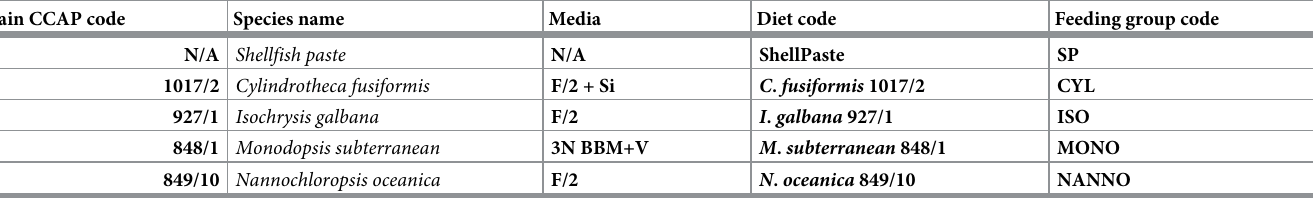
Table 1. Summary of diets employed during the feeding trial. For the live algae treatments, media used in the culture of microalgae strains and relative CCAP codes are reported. Strain CCAP